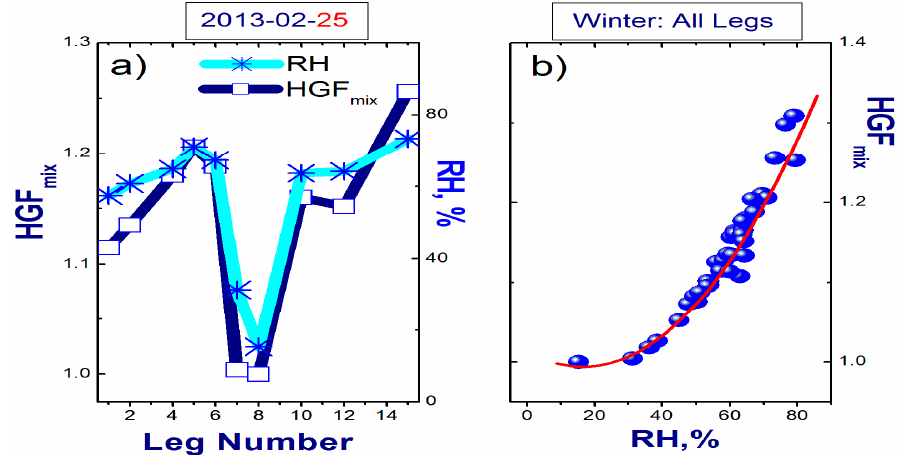
Figure 5. Example of ambient RH and RH-dependent HGF mix calculated for each FL on 25 February 2013 ( a ); scatterplot of RH-dependent HGF mix (blue dots) for all TCAP FLs used in this study with polynomial fit (red line) ( b ).